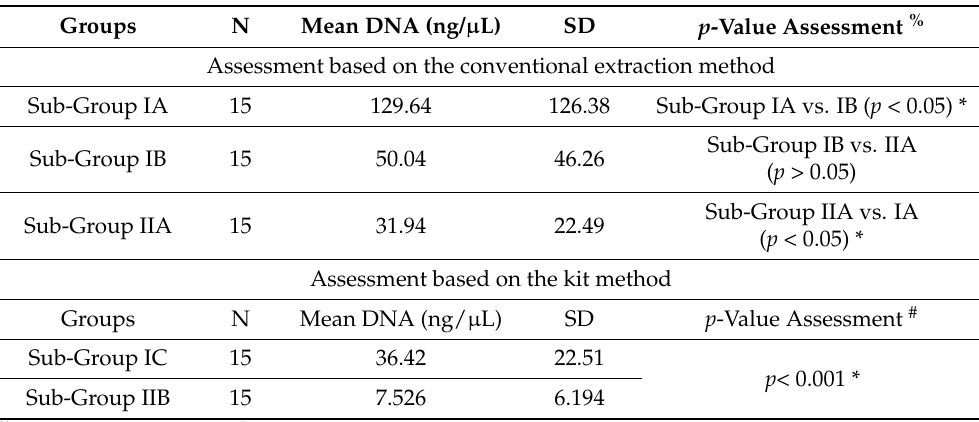
Table 6. Comparison of the mean quantity of DNA obtained between the methods from FFPET and FFT.